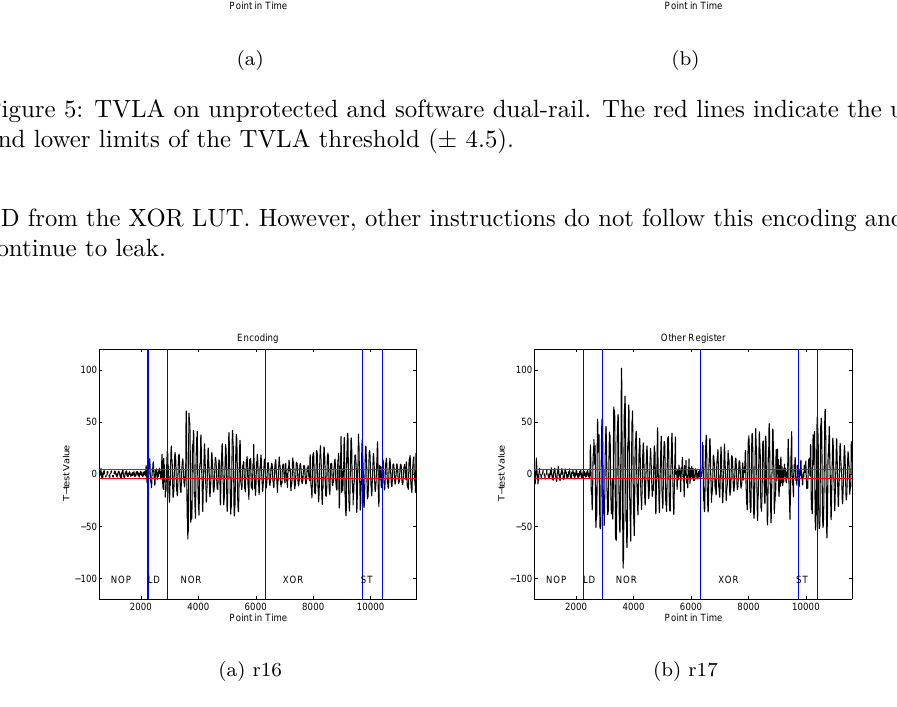
Figure 6: TVLA on encoding a1. The red lines indicate the upper and lower limits of the TVLA threshold ( ±